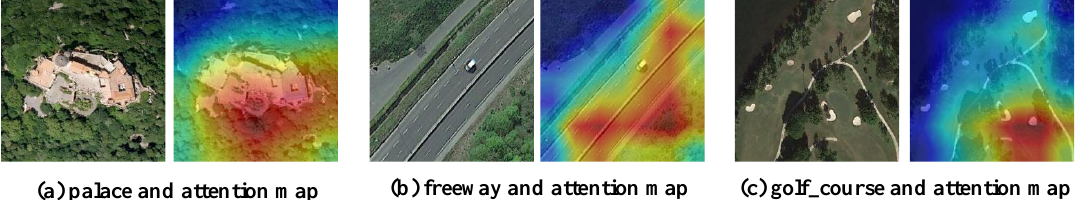
Figure 2. Attention maps of three categories generated by Gradient-weighted Class Activation Mapping (Grad-CAM) algorithm. The attention maps have high responses localized at the area related to true semantic labels .